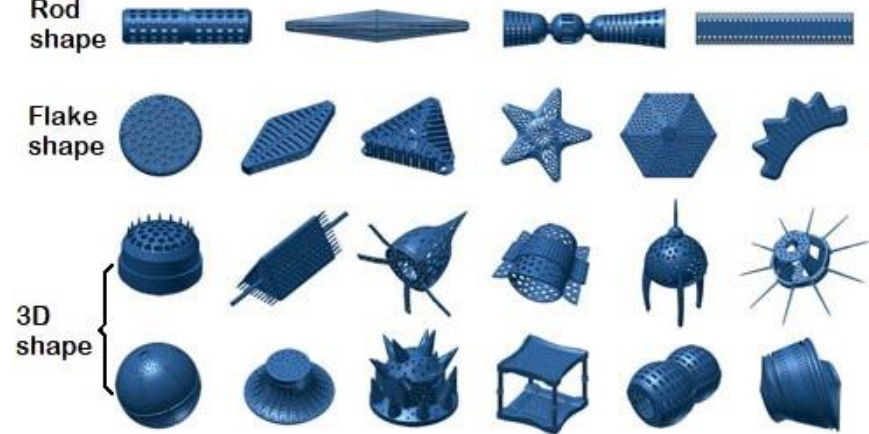
Figure 1. The unique structure of the diatom frustule. The images are 3D models [4].